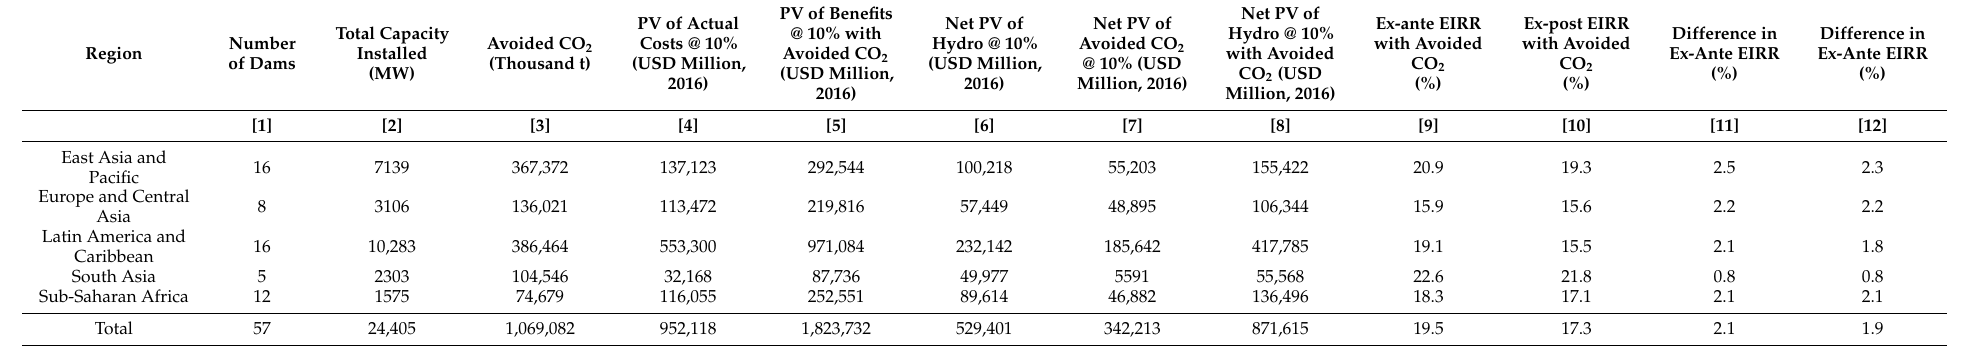
Table 13. Estimated vs. actual EIRR according to region, with and without